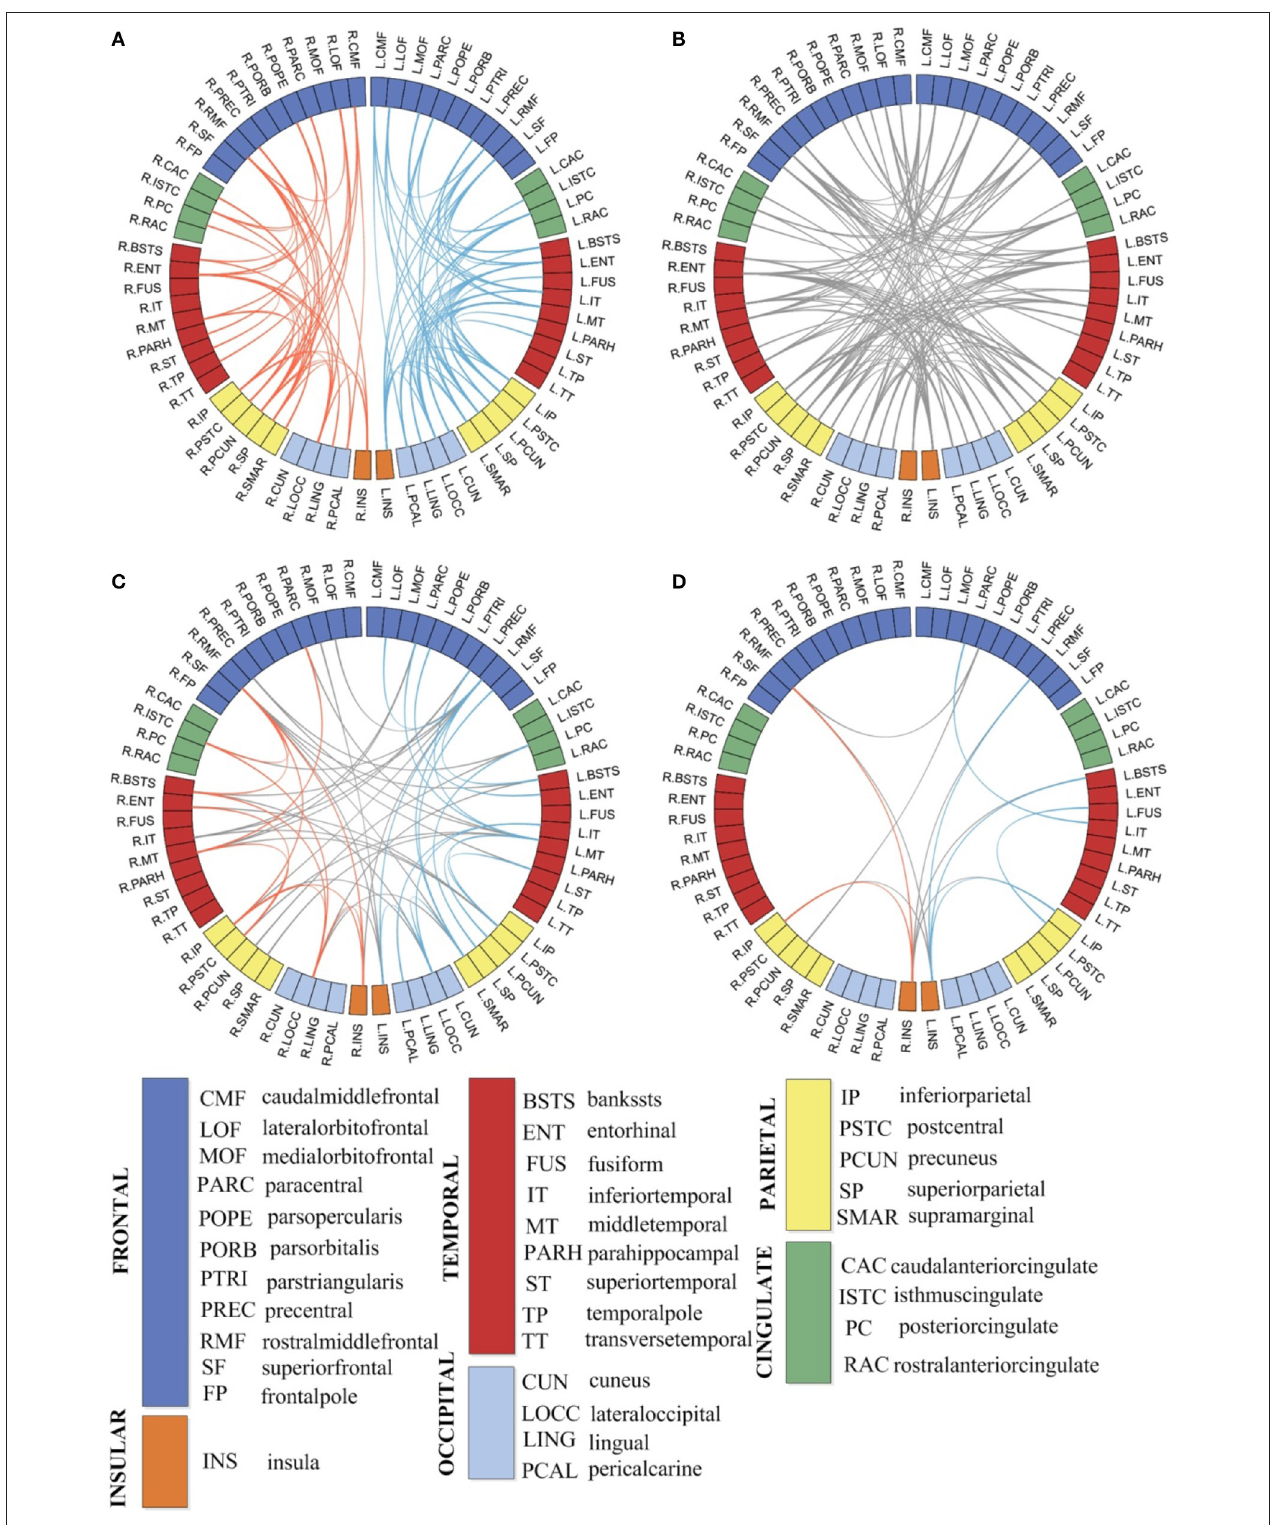
FIGURE 8 | The most discriminative edges of individual morphological brain networks in classification (A,B) and the significant correlation of the most discriminative edges with MMSE (C) and CDR (D) scores. L, left hemisphere; R, right hemisphere; the different colors of the blocks represent ROIs in different areas of the cortical surface. The blue lines represent the discriminative edges in the left hemisphere; the red lines represent the discriminative edges in the right hemisphere. The gray lines represent the discriminative edges between the left and right hemisphere.